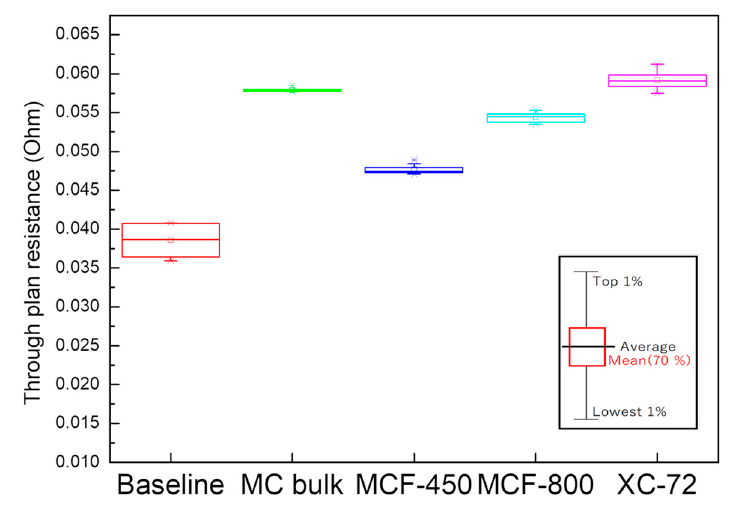
Figure 9. Through-plane electronic resistance of different carbon samples with the inset explaining the meanings of the symbols.